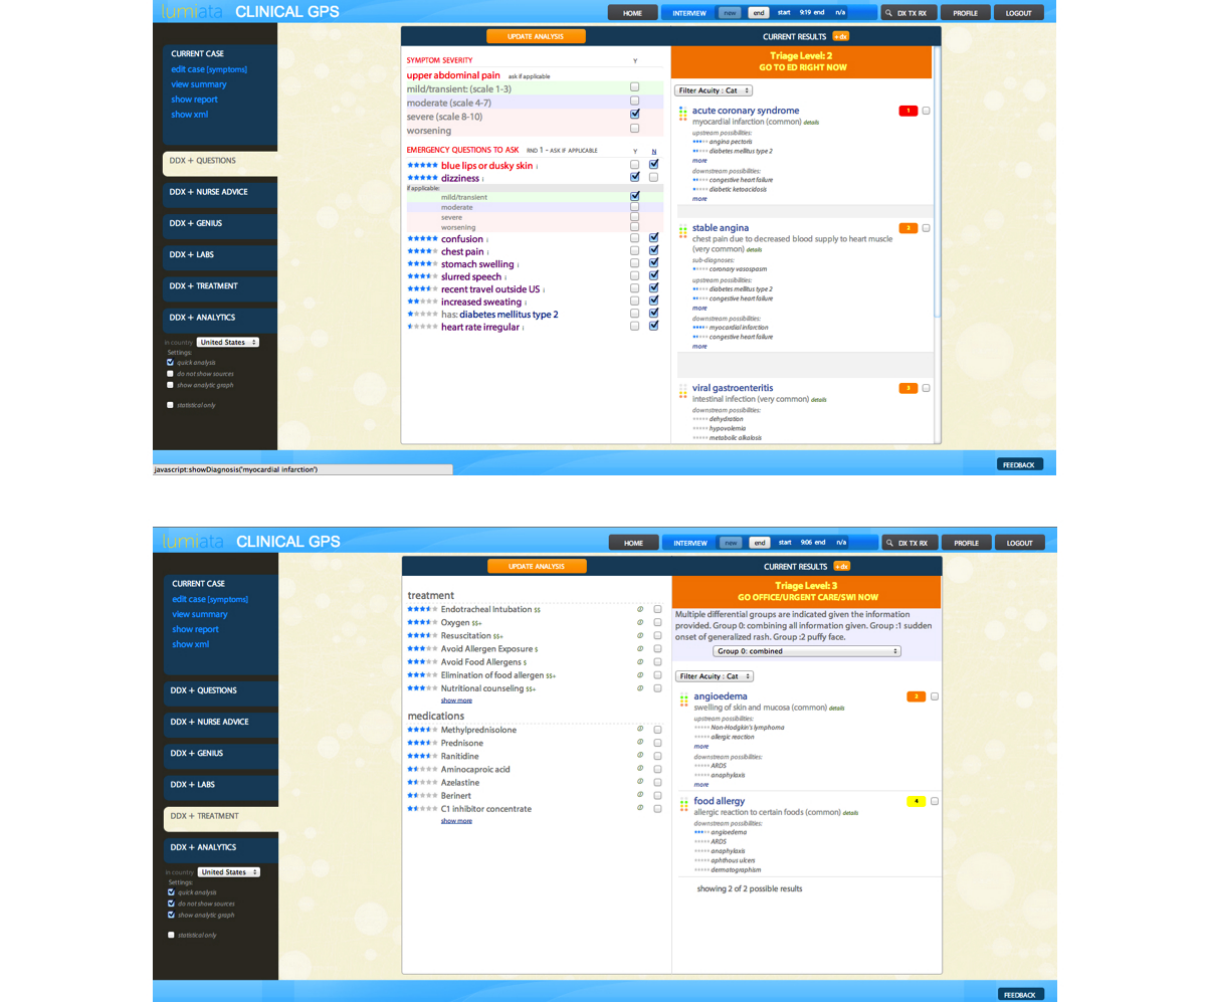
Figure 3. The clinical GPS v2.0 (cGPS) generates differential diagnoses with severity scores and upstream and downstream possibilities, and follow-up questions and tests, including associated costs (C &